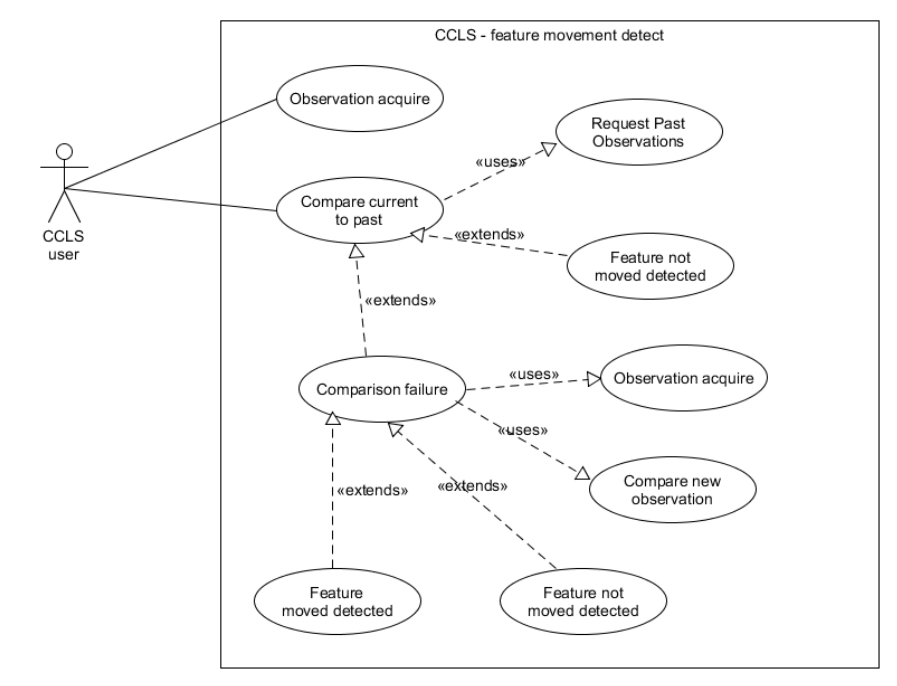
Figure 9: CCLS feature movement monitor use case UML